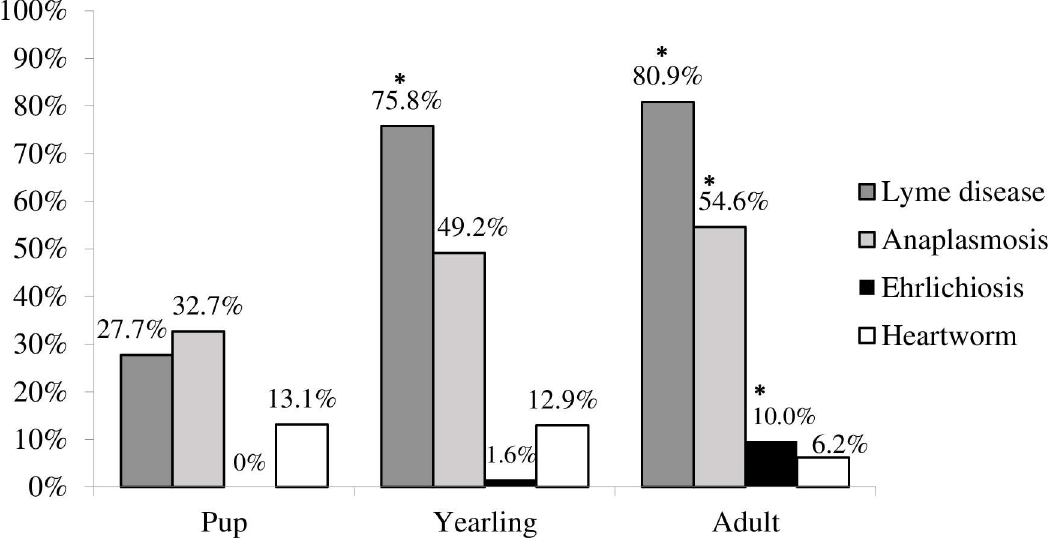
Fig 1. Wolf seroprevalence to B . burgdorferi , A . phagocytophilum , E . canis , and D . immitis by age group in Wisconsin during 1985 to 2011. Pup represents individuals between0 and 1 year old, yearling between1 and 2 years old and adult are individuals older than 2 years old. Asterisks represent significantdifferences (P < 0.05)comparedto pups. Samplesize for pup = 99–101,yearling = 62–63, adult = 207–210 dependingon the